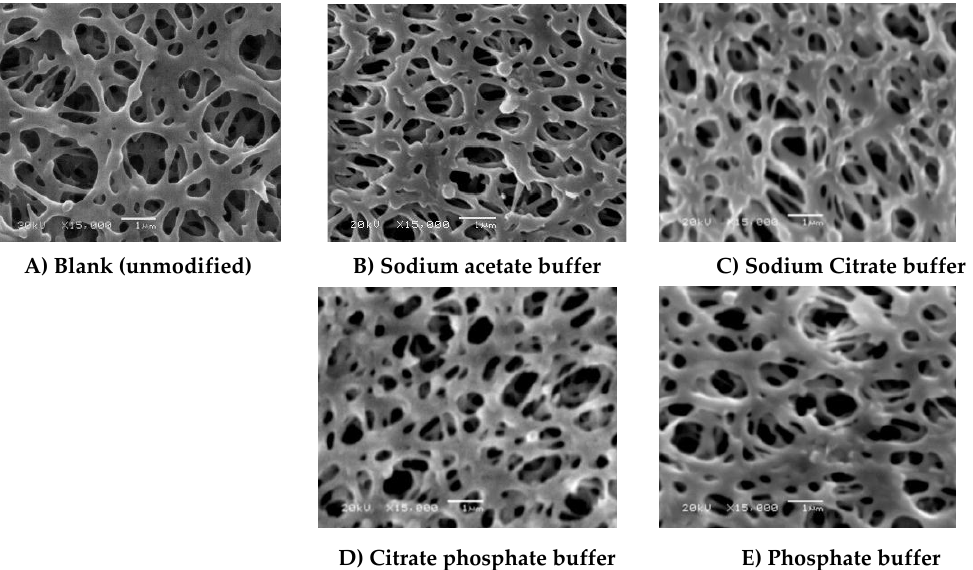
Figure 6. SEM photos (15,000× magnification, 1 µm bar) of ( A ) Blank membrane and ( B – E ) modified membranes using different buffers. Common modification condition are 4.8 mM ferulic acid, 0.5 U∙mL −1 laccase, 25 °C, pH 5 using 0.1 M buffer, and 2 h modification time: ( B ) Sodium acetate buffer; ( C ) Sodium citrate buffer; ( D ) citrate phosphate buffer and ( E ) phosphate buffer. Table 2. Flux reduction (% compared to blank) due to modification and (irreversible) protein adsorption under different modification conditions. Contact angle, layer thickness (model membrane), grafting yield, and total protein adsorption (reversible + irreversible) of some tested membranes in this study. Common modification condition is 4.8 mM ferulic acid, 0.5 U∙mL −1 laccase, 25 °C, pH 5, 0.1 M sodium acetate buffer, 2 h modification time.